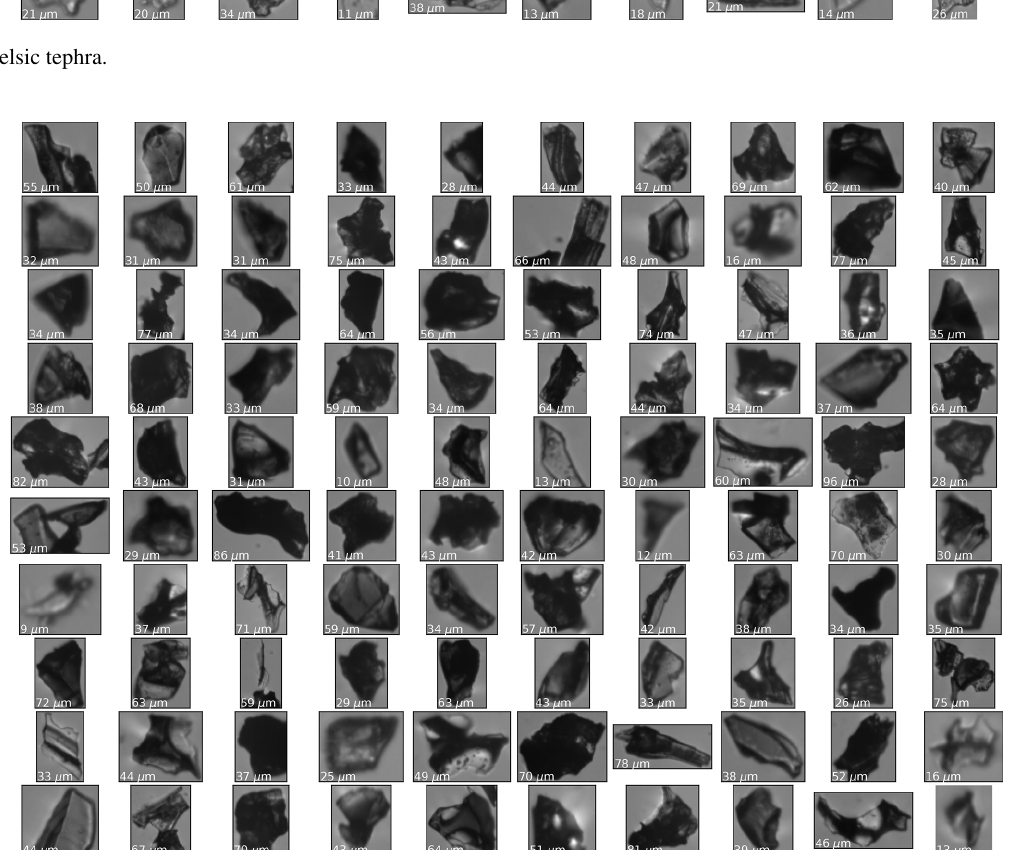
Figure C3. Basaltic tephra.